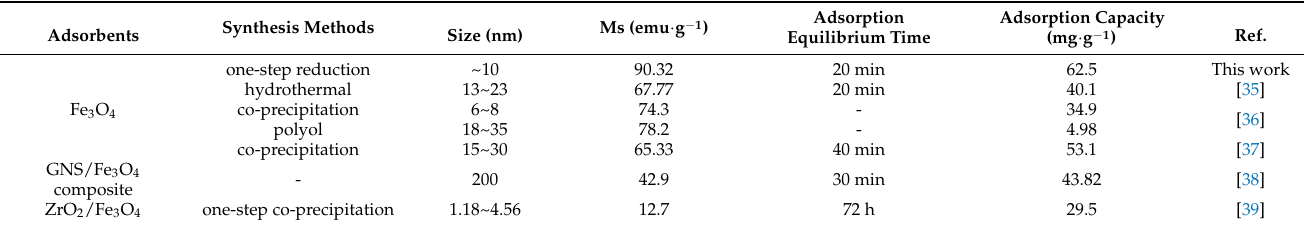
Table 2. Adsorption capacity of Fe 3 O 4 adsorbents prepared by different methods.